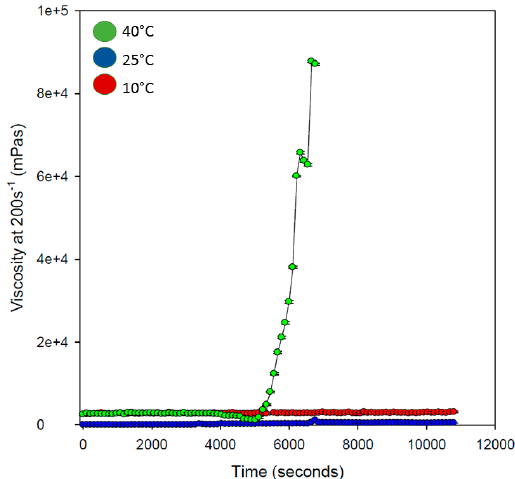
Figure 9. Rheological evaluation of the hydrogel at 10, 25 and 40 °C, for determination of change in viscous nature of the pH-responsive hydrogel.